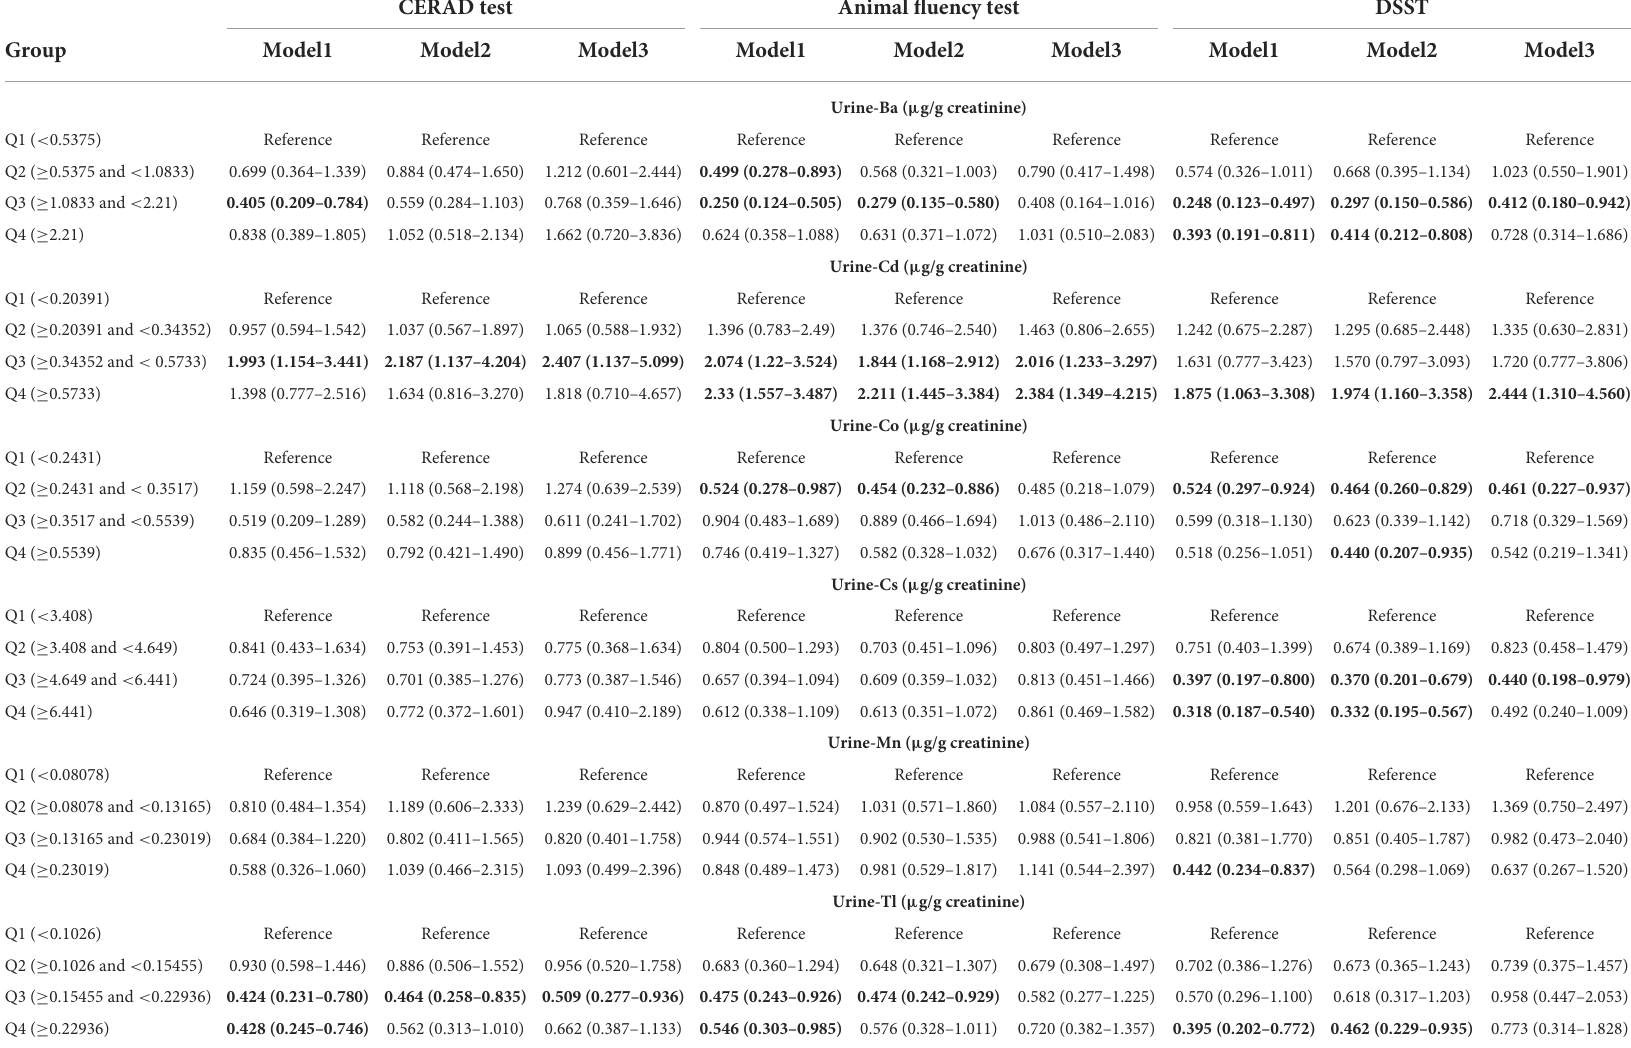
TABLE 3 Weighted odds ratios (95% confidence intervals) of low cognitive performance by quartiles of metals level, NHANES